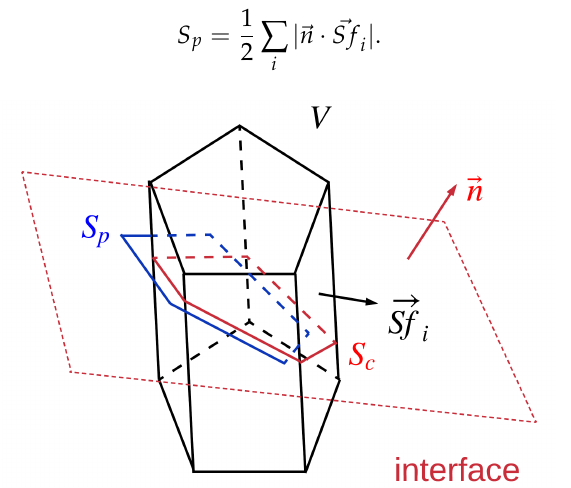
Figure 2. A polyhedron with volume V is cut by an interface with (cid:126) n being its unit normal vector. Each face of the polyhedron has a surface area vector (cid:126) Sf magnitude is the face area. S c is the common surface of the polyhedron and the interface. S p is half of the projected area.